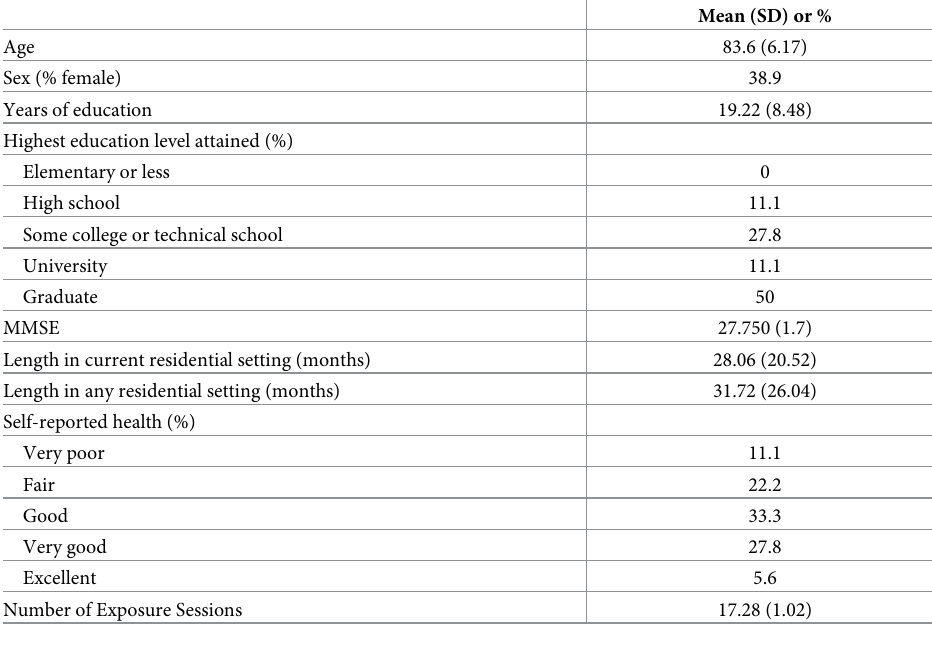
Table 1. Participant demographic information (N =